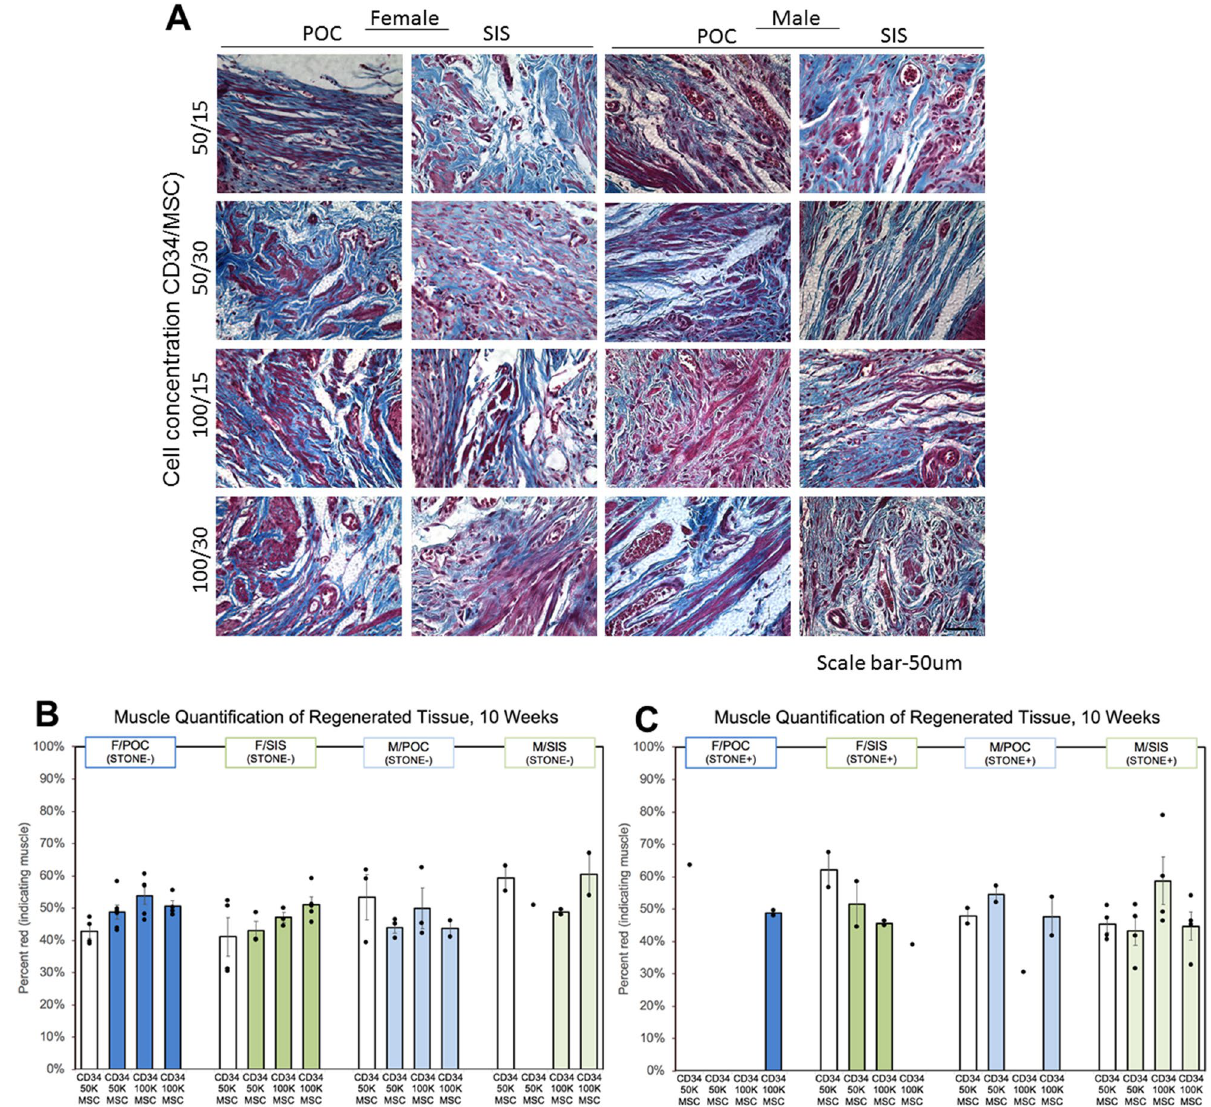
Figure 3. Masson’s trichrome stains of 10-week regenerated rat bladder tissue following augmentation (40 ×). ( A ) Images of female and male bladder tissue sections show the distribution of muscle and collagen in the regenerated tissue that is representative of the animals in that graft group (n = 4–6 before subsets; 10 images per animal). Analysis of the regenerated tissue examines muscle tissue area as a percent of total regenerated bladder tissue for each group further divided into ( B ) stone negative (S−) and ( C ) stone positive (S+) rats. Further analysis shows a potential trend towards increased percent muscle area at higher seeding densities. In S− F/POC and F/SIS groups, a greater fraction of animals in each seeding group achieved ≥ 45% muscle as seeding densities increased, however, group differences were generally not statistically significant. A comparison of seeding groups CD34-50/MSC15 and CD34-100/MSC15 (F/POC S−) generated the only statistically significant group difference (p < 0.05). Scale bar: 50 μm. Error bars represent ±